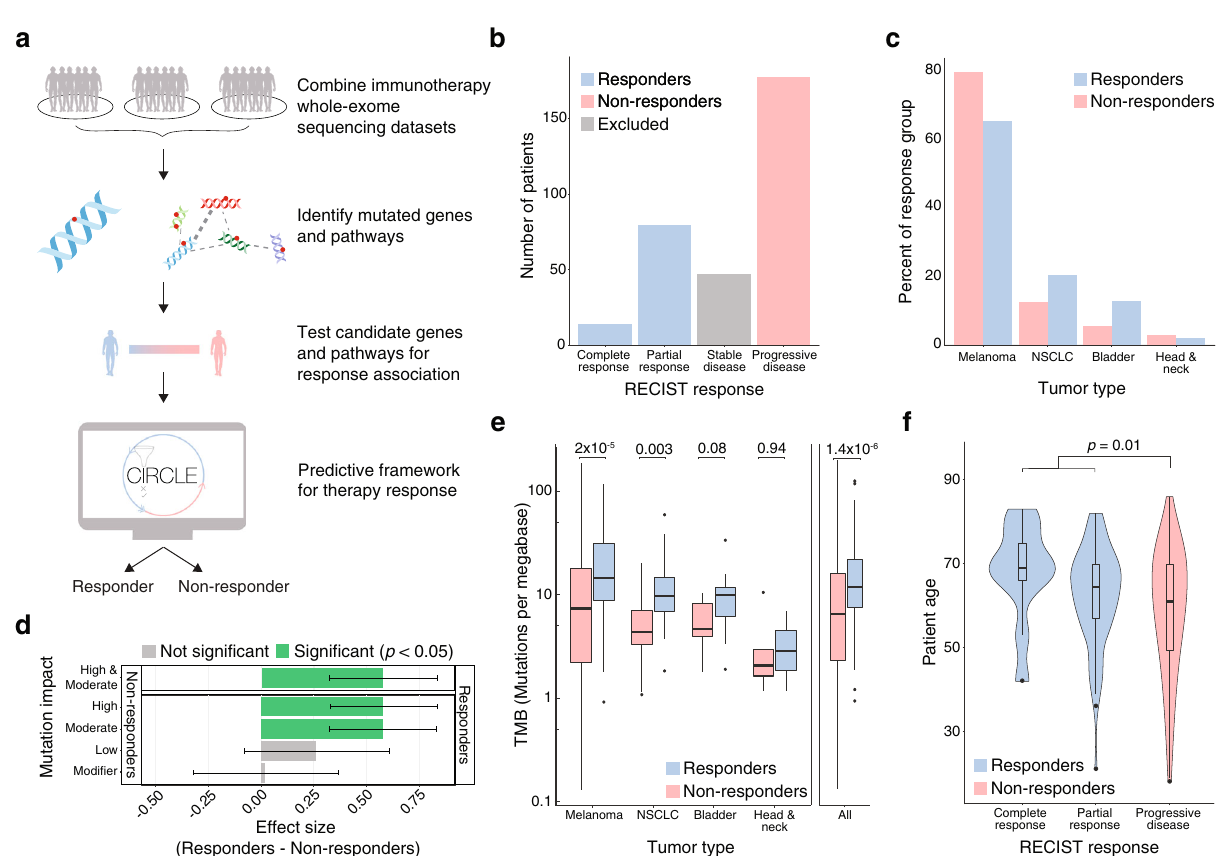
Fig. 1 An aggregated cohort of immune checkpoint blockade (ICB) patients replicates known correlations between tumor mutational burden and age with treatment response. a Overview of the two-stage approach for immunotherapy response prediction. We pooled 6 cohorts of immune checkpoint blockade (ICB) recipients with matched whole-exome sequencing (WES) and Response Evaluation Criteria in Solid Tumors (RECIST) classi fi cation. We identi fi ed genes and pathways under positive selection and tested the nominated genes and pathways for their ability to predict ICB response. The signi fi cant predictors were used to develop and test an ICB response prediction algorithm. b Number of patients from the aggregated set of 6 cohorts in each RECIST response group. Patients with stable disease were excluded from analyses and the RECIST classi fi cations of complete response and partial response were both considered responders. c Proportion of tumor types amongst ICB responders and non-responders. d Enrichment (effect size, Hedge ’